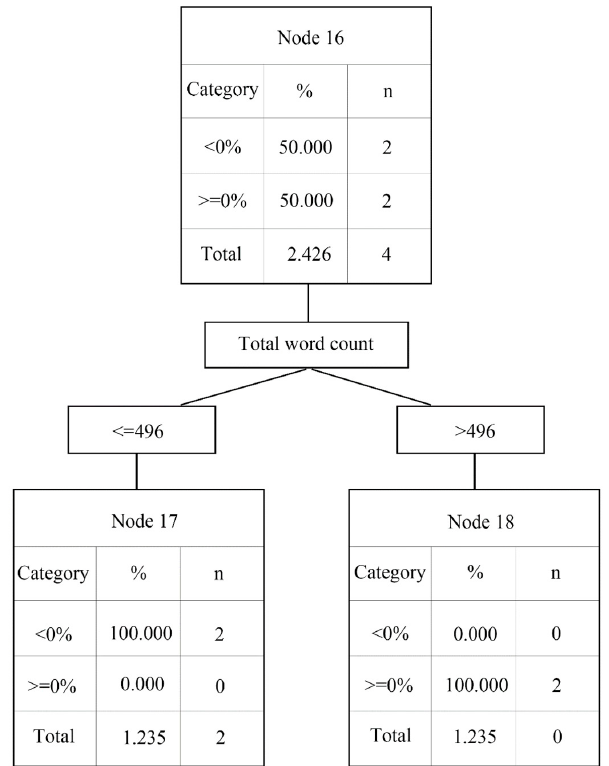
Figure 9. The classification results for N08 (New York Post) at Nodes 16–18.